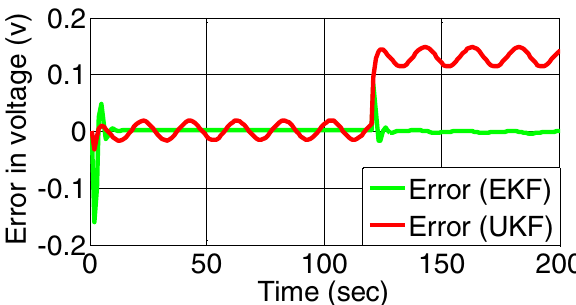
Figure 10. Error/residual evaluation for Voltage across charge transfer capacitance estimation by EKF and UKF during